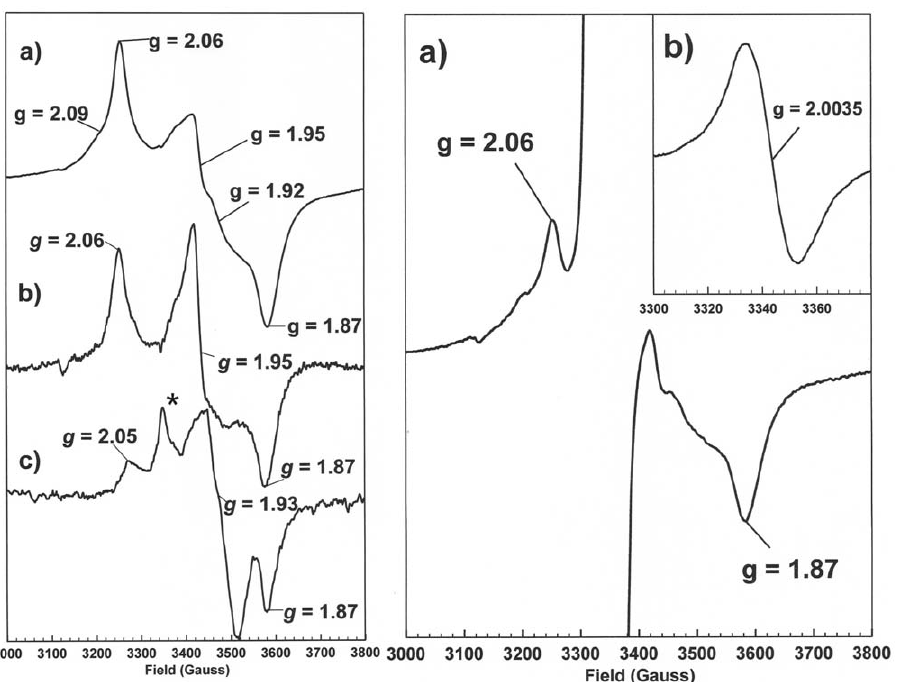
Figure 3. Left hand panel: X-band EPR spectra of PduS reduced using sodium dithionite, a) WT reduced using ten equivalents of dithionite showing interaction between two [Fe-S] clusters, b) WT reduced using three equivalents of dithionite, c) C270A mutant reduced using ten equivalents of dithionite (this spectrum is the sum of 16 scans), the asterisk marks a small signal from an unassigned (non-flavin) radical species. Right hand panel: X-band EPR spectra of PduS reduced using an excess of NADH, a) shows a wide sweep width with and is expanded vertically to reveal the features arising from the [4Fe-4S] 1 + centre, b) shows a spectrum of the same sample recorded under conditions that favour the accurate registration of flavosemiquinone radical spectra and over a narrower sweep width. Experimental conditions were: microwave power 0.5 mW, modulation amplitude 5 G, modulation frequency 100 KHz, temperature 12 K for all but right hand panel spectrum b) where they were: microwave power 10 m W, modulation amplitude 1 G, modulation frequency 100 KHz, temperature